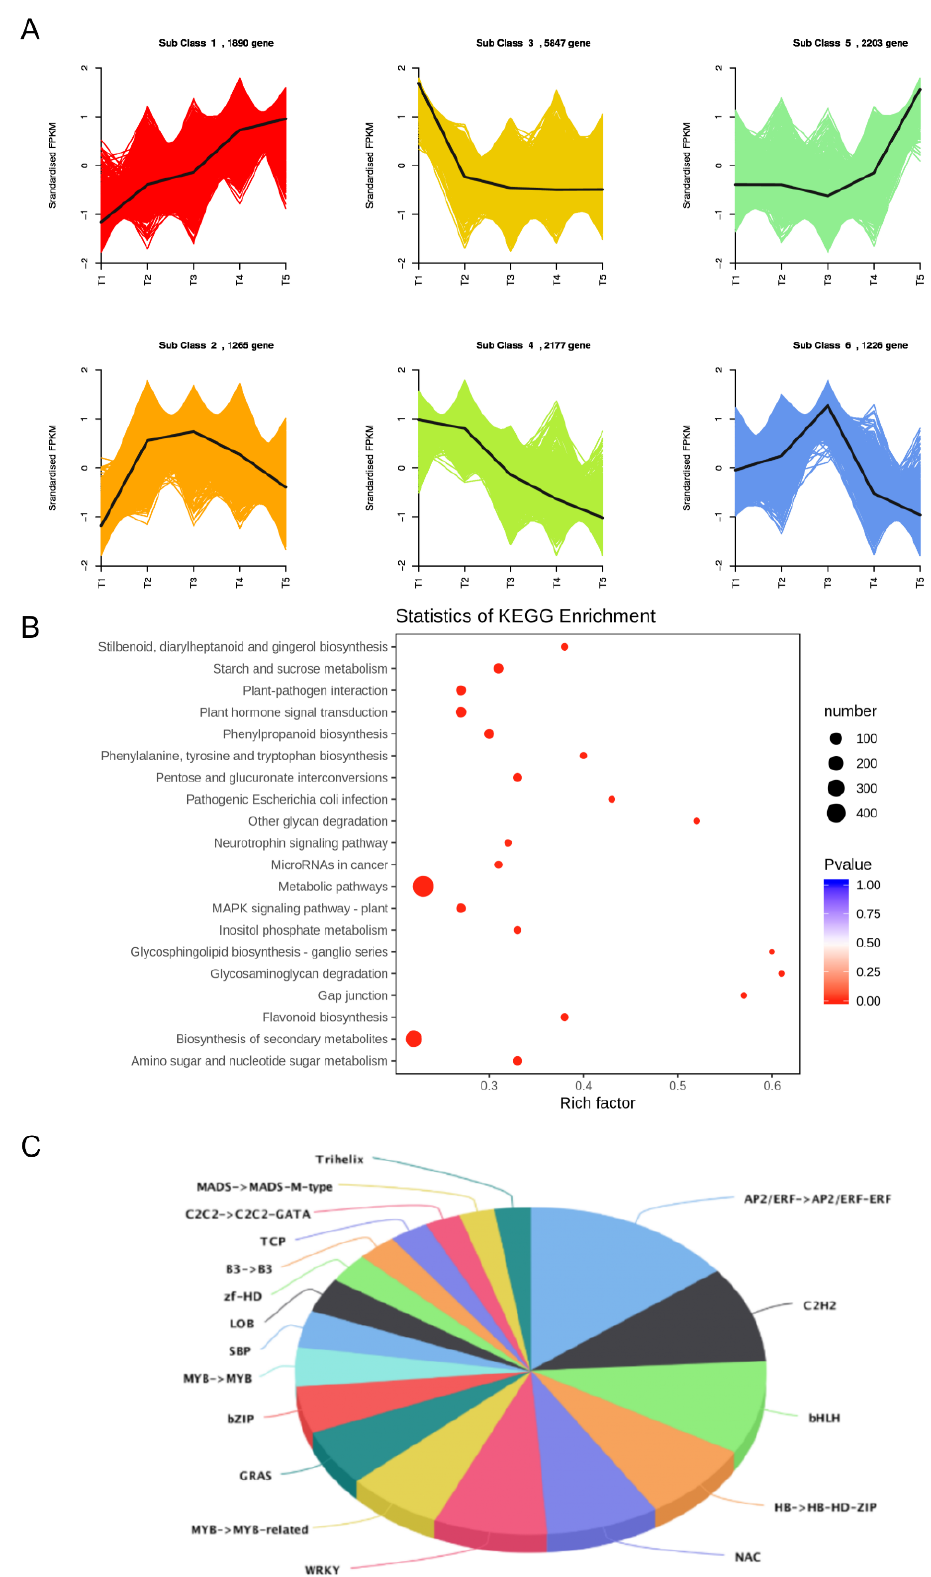
Figure 3. ( A ): six differential gene expression classification. The abscissa represents the sample, and the ordinate represents the standardized expression amount. ( B ): KEGG enrichment analysis of Class 3 gene. ( C ): Transcription factor families enriched in the cluster.